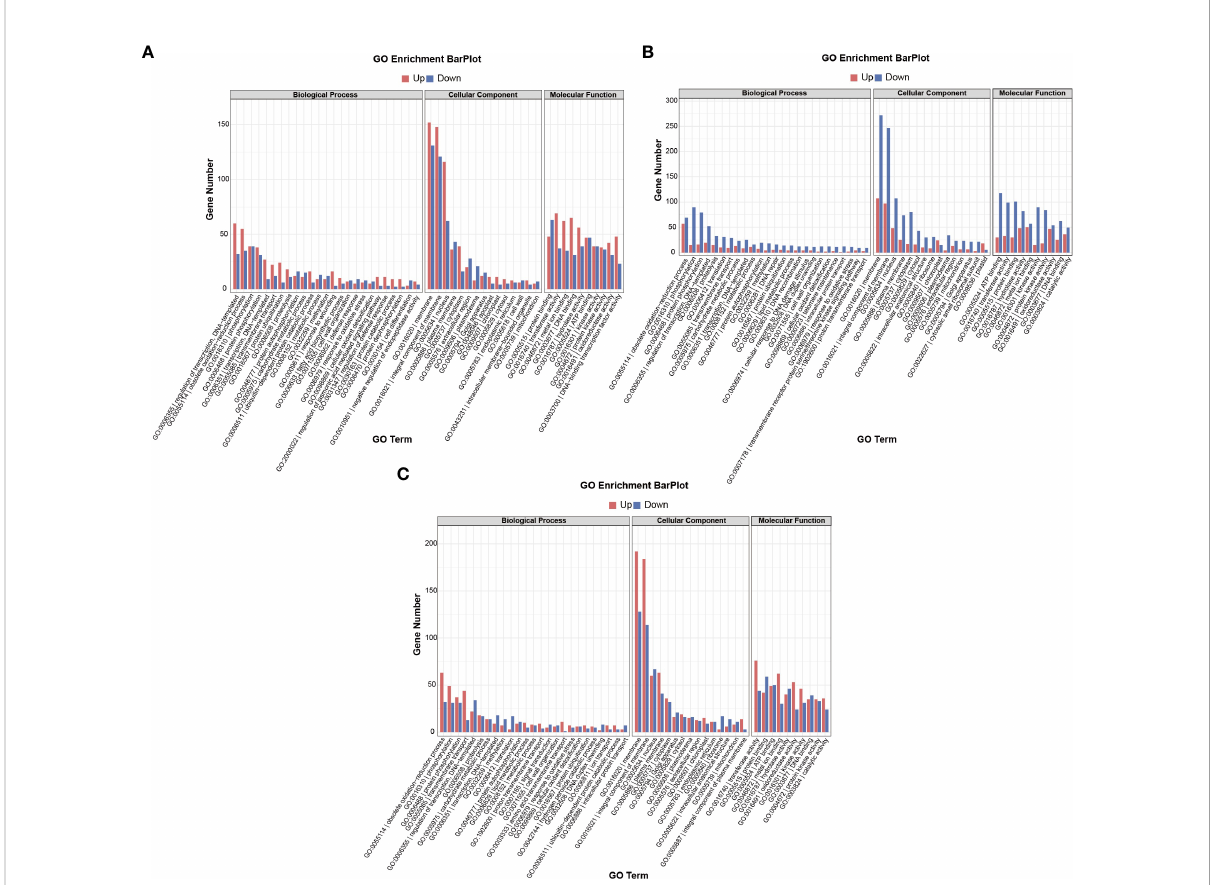
FIGURE 5 GO term annotations of DEGs in B73 and bhlh112 under the different treatments. (A) b112_CKvsB73_CK; (B) b112_AvsB73_A; (C) b112_IvsB71_I. CK = control, A = exogenous ABA, I = exogenous